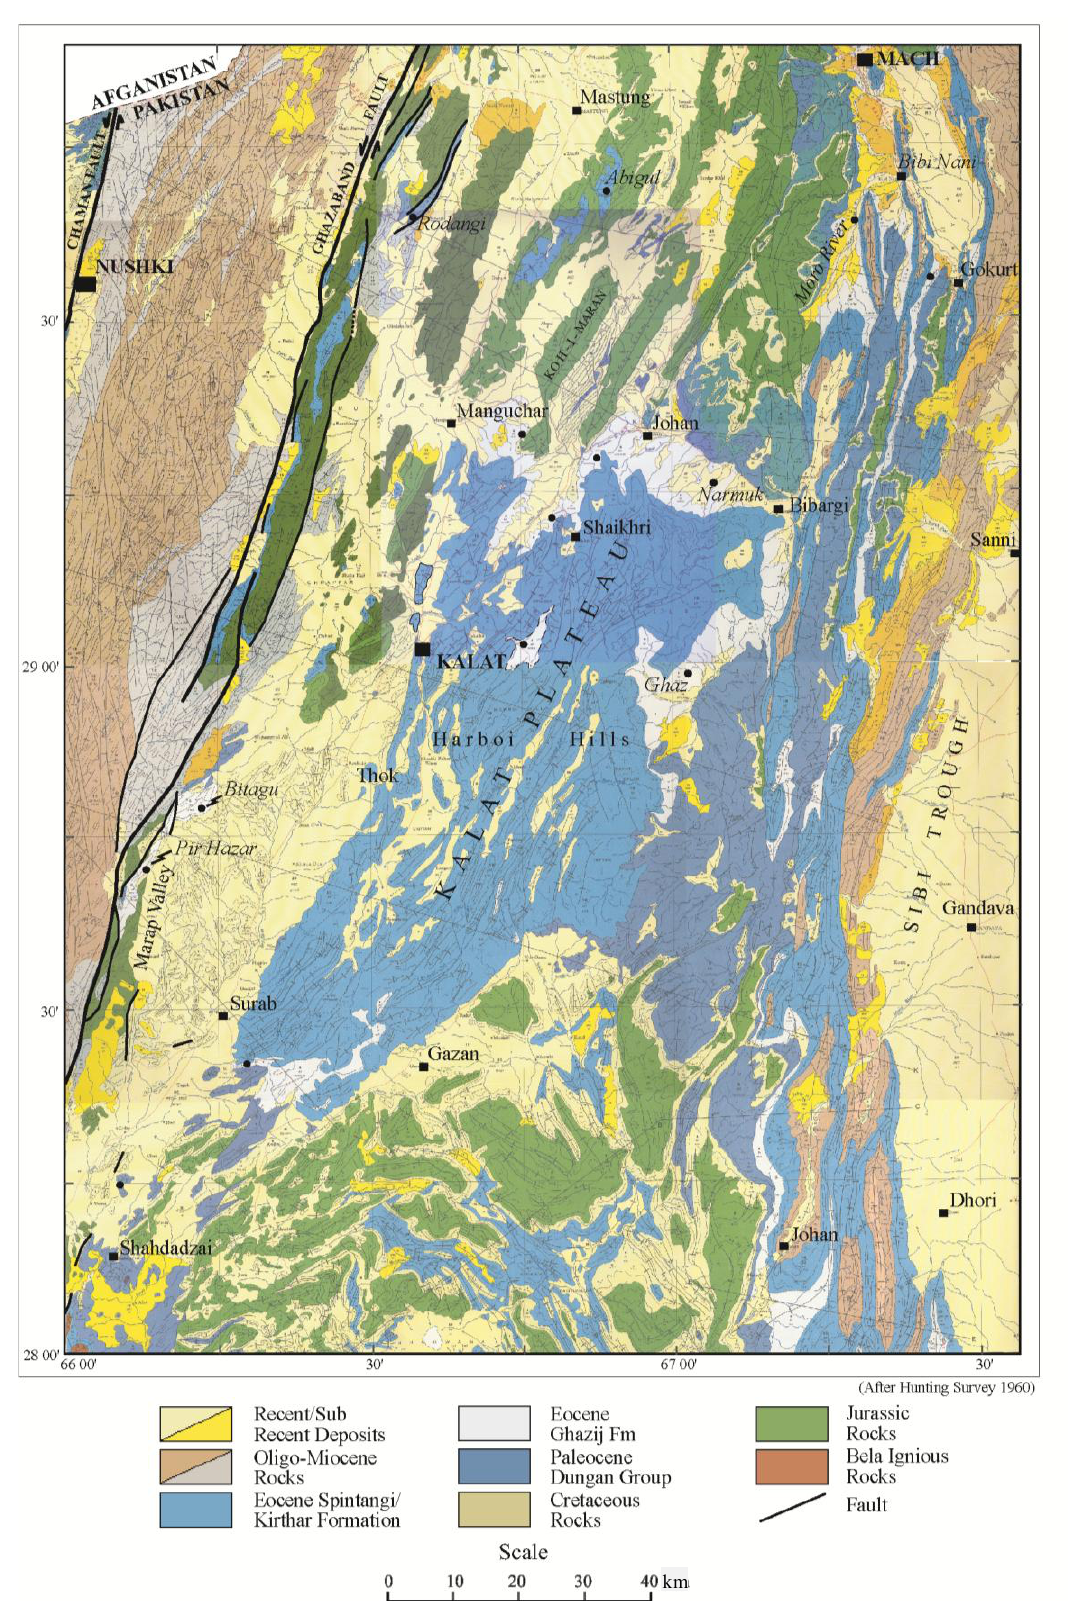
Figure A1. Geological map and geographic localities of Kalat and adjoining areas (adapted from Hunting Survey Corporation